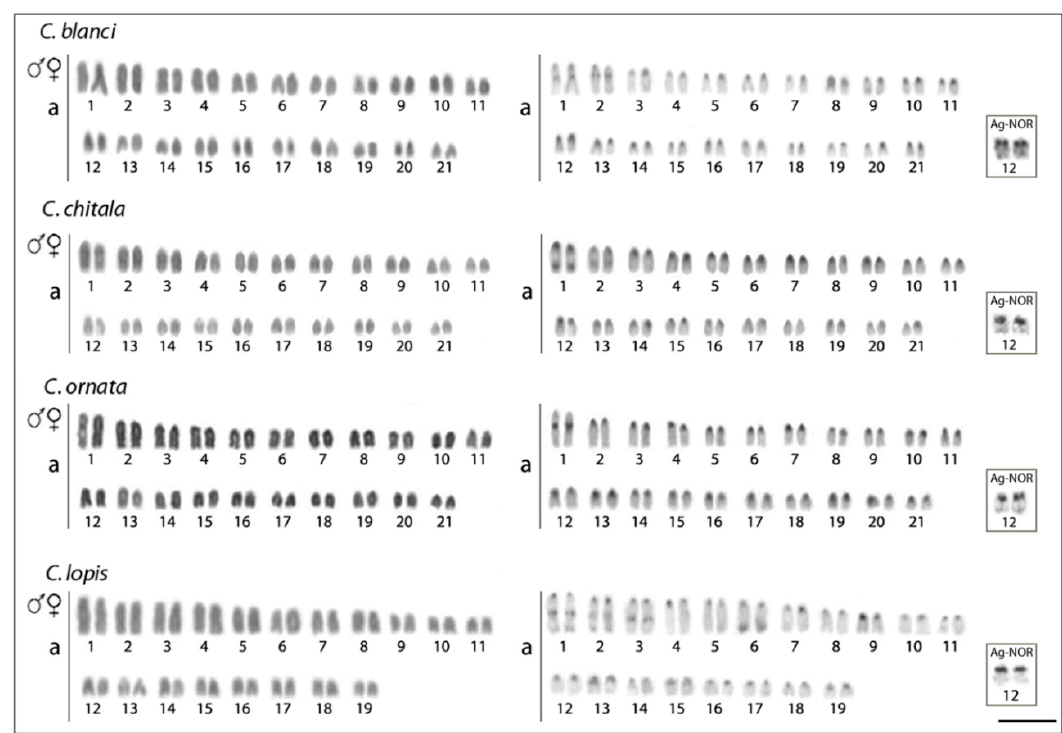
Figure 2. Karyotypes of four Chitala species analyzed after conventional Giemsa staining (left) and C-banding (right) procedures. The Ag-nucleolar organizer regions (Ag-NORs) pairs are highlighted in boxes. Scale bar = 5 μ m.